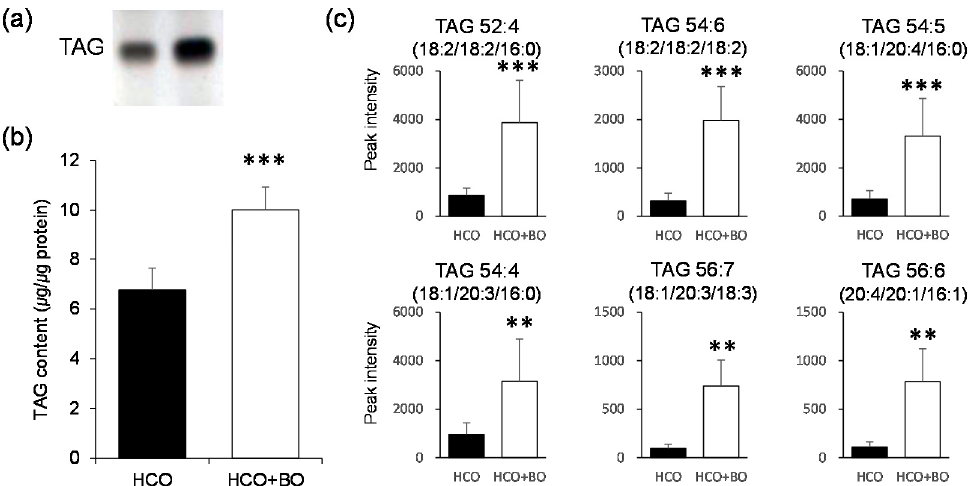
Figure 1. Triacylglycerol (TAG) content in the epidermis of guinea pigs fed a hydrogenated coconut oil (HCO) diet for 10 weeks (group HCO) or 8 weeks followed by 2 weeks of borage oil (BO) diet (group HCO + BO). Total TAG content was analyzed by high-performance thin-layer chromatography (HPTLC). ( a ) Representative band and ( b ) densitometric analysis. ( c ) Analysis of TAG species was performed by direct-infusion electrospray mass spectrometry (ES-MS). Values are means ± SD ( n = 5). ** p < 0.01, *** p < 0.001 vs. group HCO by the unpaired Student’s t test.